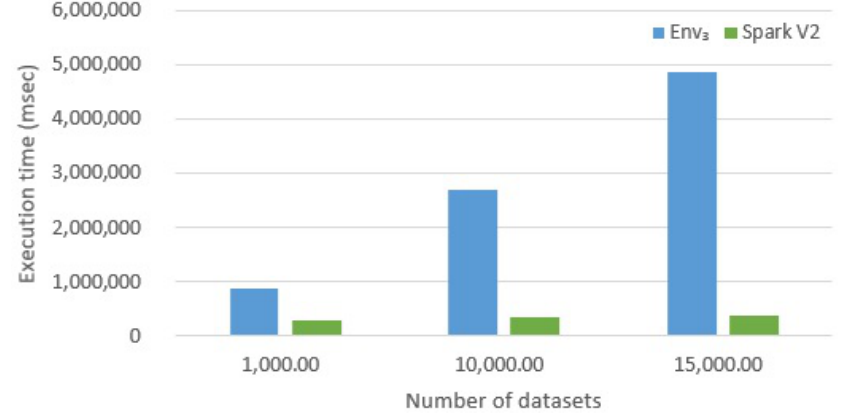
Figure 8. Comparing average execution times of of Step 4 for the basic Spark implementation (denoted as Env 3 ) and the enhanced Spark implementation (denoted as Spark V2 ).